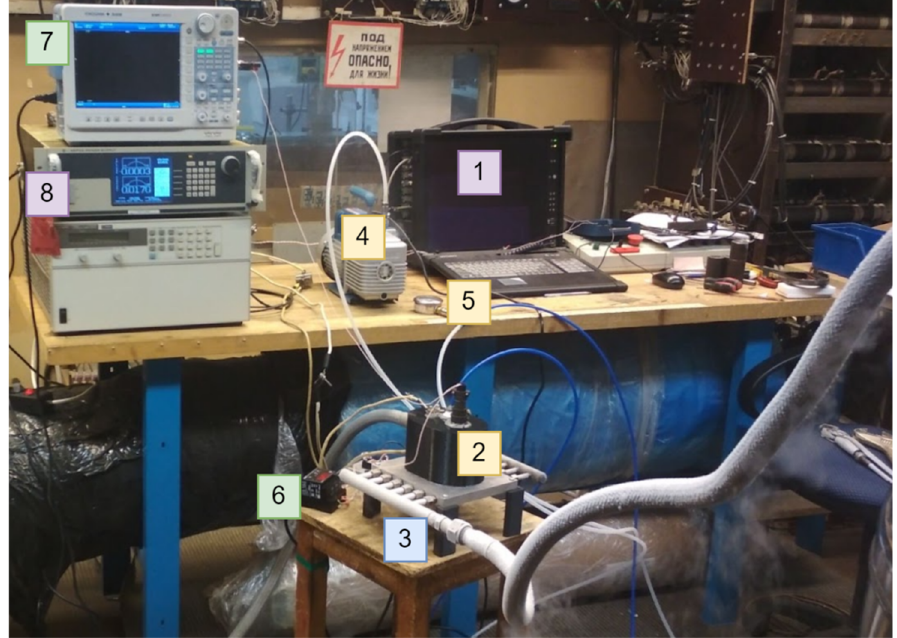
Figure 2. Photo of the test bench. 1—computer that controls the source of test signals, 2—vacuum casing, 3—radiator with tubes, 4—vacuum pump, 5—pressure sensor, 6—temperature indicator, 7—oscilloscope recorder, and 8—source of test signals.